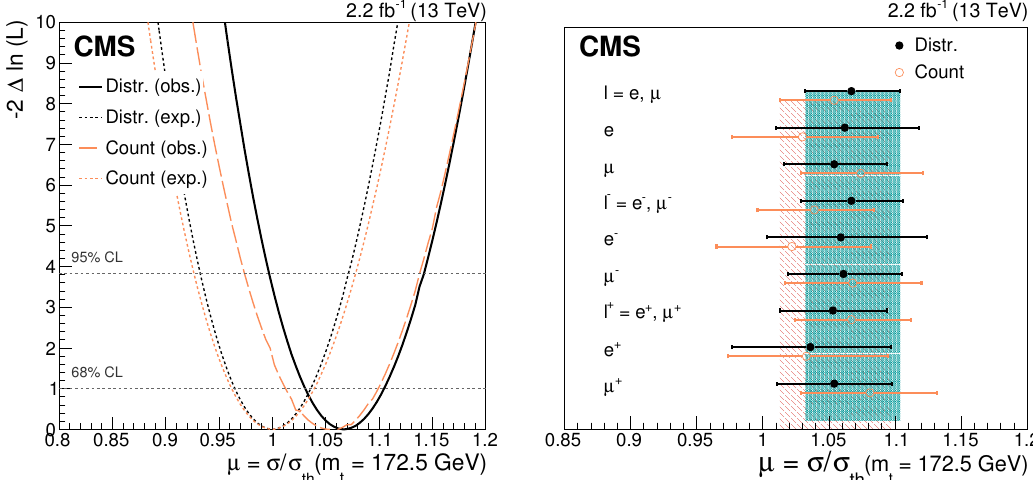
Figure 3 . (Left) The observed (solid curve) and expected (dashed curve) variation of the likelihood as a function of the signal strength (cid:22) for the distribution-based analysis. The expected curve is obtained by performing the (cid:12)t using simulated events with m t = 172 : 5 GeV. For comparison, the corresponding curves for the counting cross-check analysis are also shown. The two horizontal lines represent the values in the PLR that are used to determine the 68% and 95% con(cid:12)dence level (CL) intervals for the signal strength. (right) Comparison of the values of the signal strength extracted for di(cid:11)erent combinations of events for the distribution-based default analysis (solid circles) and the cross-check counting analysis (open circles). The horizontal bars represent the total uncertainties, except the beam energy uncertainty. The shaded bands represent the uncertainty in the (cid:12)nal combined signal strength obtained from the distribution-based and cross-check